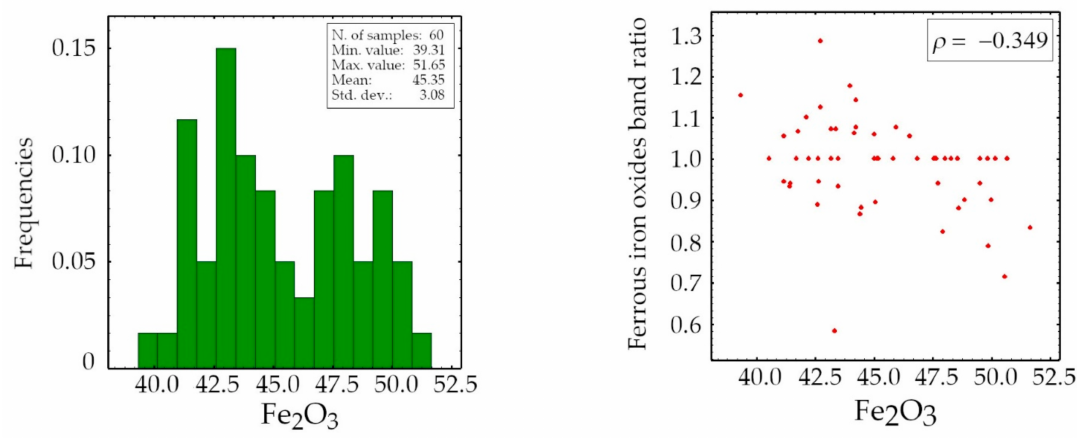
Figure 3. Histogram of Fe 2 O 3 (%) of samples ( left ) and correlation with band ratio ferrous iron oxides: Band4/ Band11 ( right ).